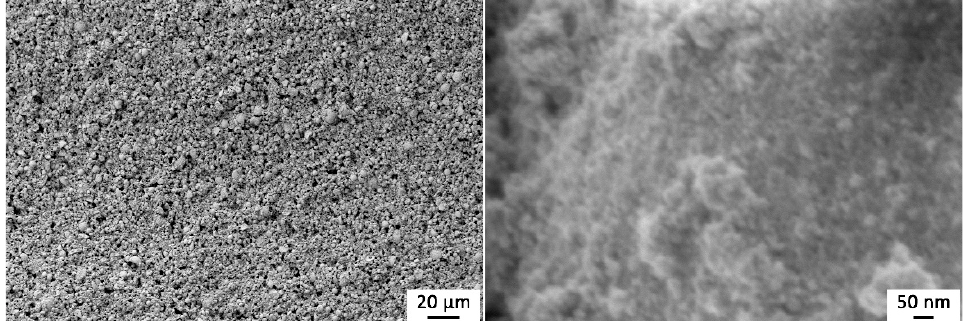
Figure 6. Microstructure of the printed SnO 2 thick film.